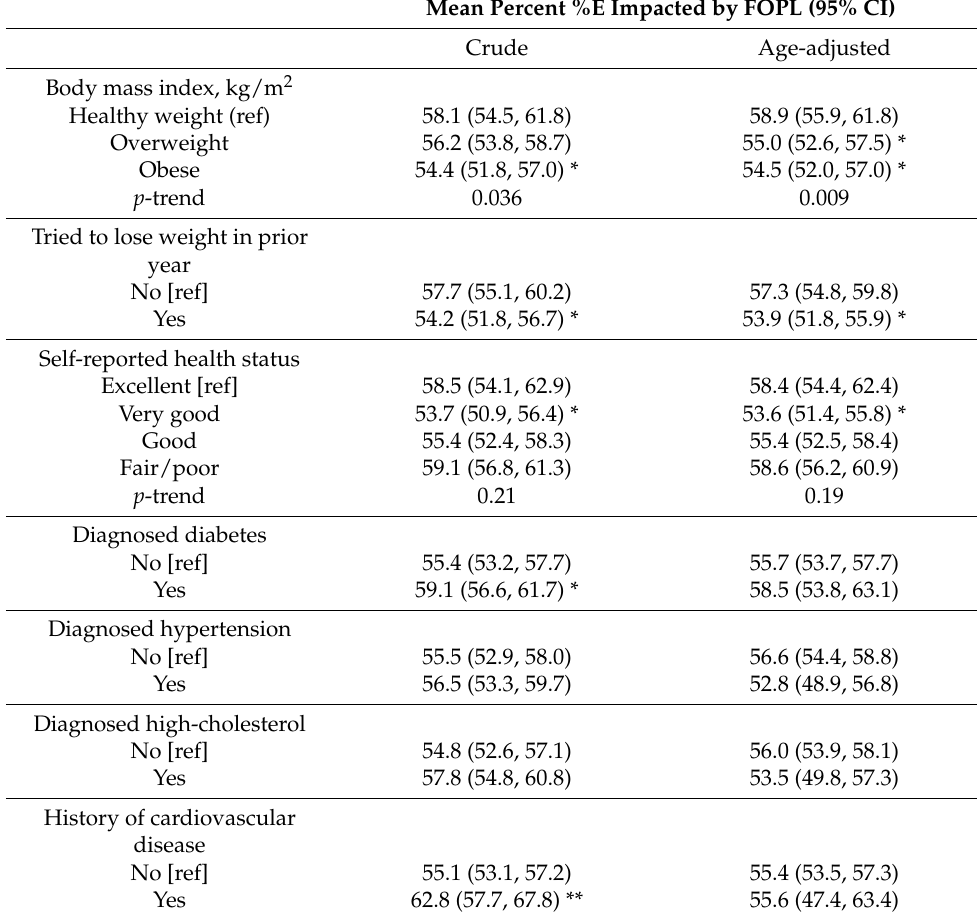
Table 3. Proportion of population’s dietary energy (%E) impacted by FOPL among US adults (age ≥ 20 year) by health behaviors and conditions,